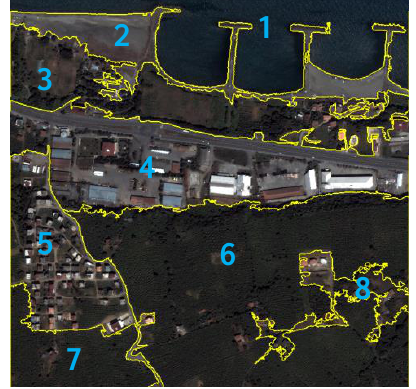
Figure 2. Extracted regions on the image.